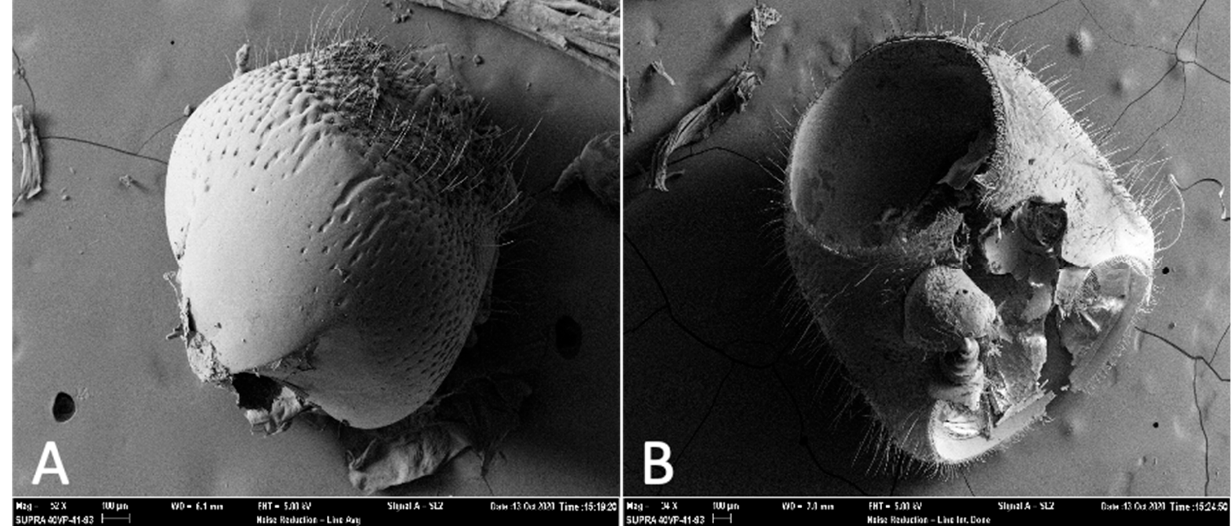
Figure 1. Scanning electron images of head and thorax of Ips confusus adult male. ( A ) Posterior dorsal view of head (52 × magnification) and ( B ) pronotum (34 × magnification). No stridulatory structures present. See Figure 2 for comparison of stridulatory structures on female head and thorax.